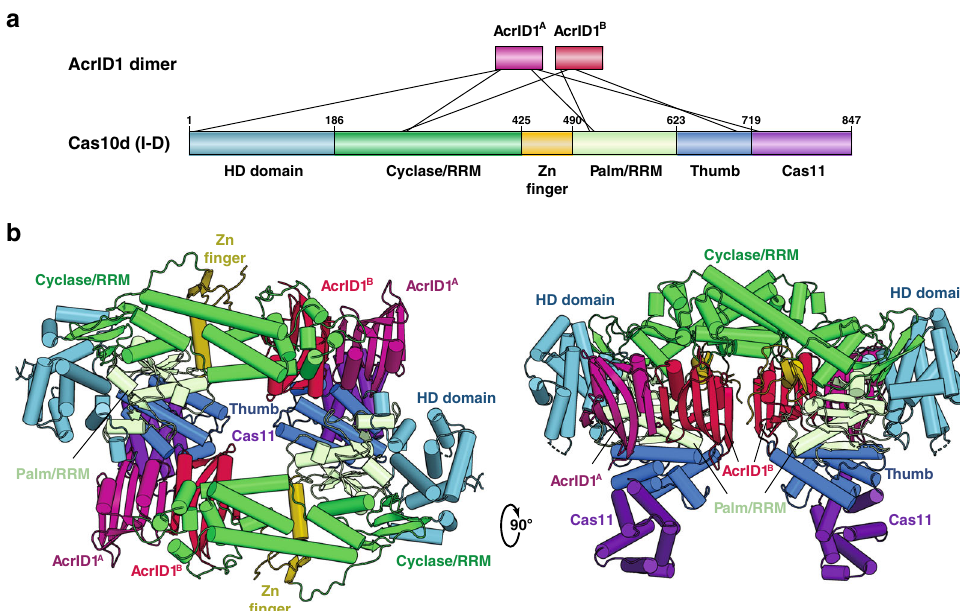
Fig. 1 Overview of the S. islandicus Cas10d-SIRV3 AcrID1 complex. a Interaction map showing the two monomers of the SIRV3 AcrID1 dimer (A and B, purple and red, top) and the individual domains of the S. islandicus Cas10d protein (as indicated, bottom). Residue numbers at domain borders are indicated. b Overview of the 2:4 complex of Cas10d and AcrID1 in two orthogonal views with colours as in a. Left, top view with the two molecules of Cas10d in the top left and bottom right corner of the structure (blue and green), bridged by two AcrID1 dimers (red/purple); Right, side view with the two molecules of Cas10d on the left and